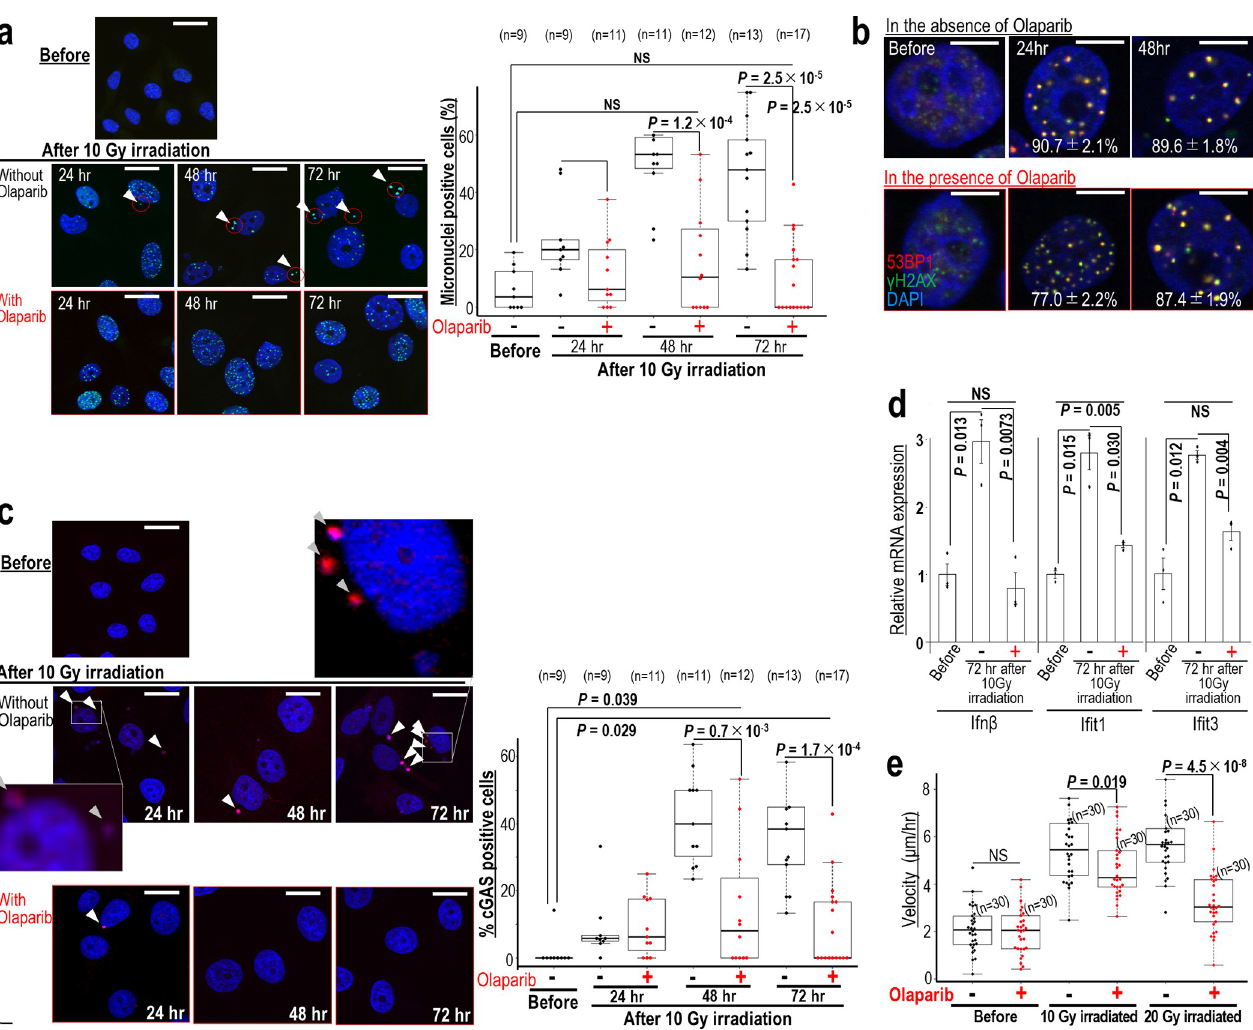
Fig 3. Genomic destabilization-associated phenotypes induced by radiation are suppressed by Olaparib. ( a , b ) MCF7 cells were irradiated with γ -ray (10 Gy) in the presence or absence of Olaparib. Micronuclei were identified by immunofluorescence staining with a γ H2AX antibody and DAPI ( a ). Arrowheads show micronuclei. Scale bars in images, 30 μ m. Bars show means ± s.d. Two-tailed Welch’s t-test was used for statistical analysis. Foci containing γ H2AX and 53BP1 were detected by immunofluorescence ( b ). Scale bars in images, 10 μ m. ( c ) MCF7 cells were examined 24–72 hr after 10 Gy γ -ray irradiation in the presence or absence of Olaparib. Micronuclei were identified by immunofluorescence staining with a γ H2AX antibody and DAPI. Arrowheads show cGAS- positive micronuclei. Scale bars in images, 30 μ m. Bars show means ± s.d. Two-tailed Welch’s t-test was used for statistical analysis. ( d ) MCF7 cells were treated as in ( c ) and the expression of Ifn β , Ifit1 , and Ifit3 was determined (n = 3 independent experiments). ( e ) MCF7 cells were treated as in ( c ) and monitored by time lapse imaging (n numbers are indicated on the graph). Migration rates are shown as the velocity 24 to 48 hr post γ -ray irradiation. Two-tailed Welch’s t- test was used for statistical